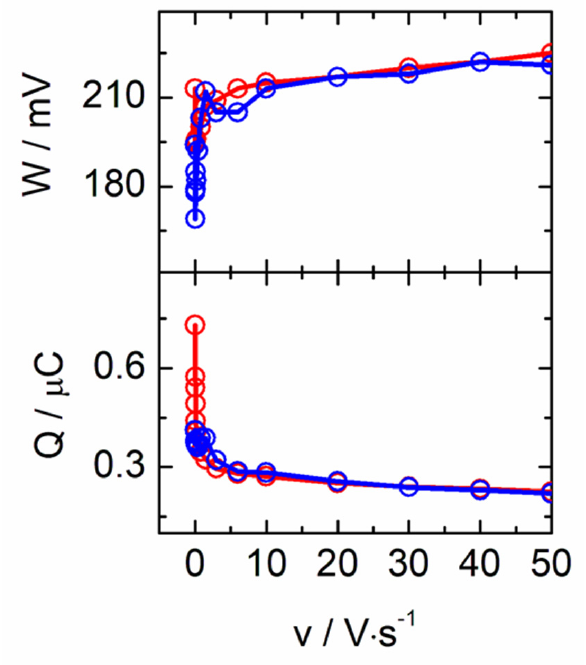
Figure 3. Charge density (Q) and peak half width (W) of the Hb-AuNTs deposited on a GC electrode in a 50 mM phosphate buffer at pH 7.4, as a function of the scan rate.